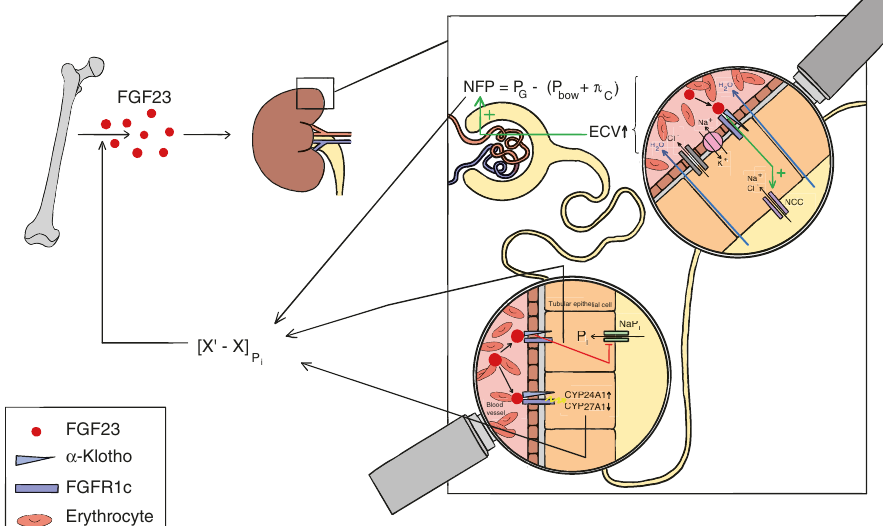
Fig. 1 Homeostatic functions of FGF23. Serum levels of phosphate are maintained within a tight range ([X ′ -X]) through constantly comparing the status quo (X) of circulating phosphate abundance with a prede fi ned set-point (X ′ ). If phosphate levels rise above the upper boundary of this range, FGF23 is induced, although the precise mechanism underlying phosphate-driven FGF23 secretion remains elusive. FGF23 restores phosphate homeostasis through its effects on the kidneys: In the proximal tubule, FGF23 reduces phosphate reabsorption by downregulating Natrium/Phosphate Cotransporters (NaP i s), inhibition of 25-OH-Vitamin D activation through downregulating CYP27A1 as well as enhanced catabolism of 25-OH-Vitamin-D via upregulation of CYP24A1. The latter two changes also decrease intestinal phosphate uptake. Moreover, FGF23 enhances sodium and chloride reabsorption in the distal tubule by fostering Na + /Cl − Cotransporter (NCC) activity, which yields an expansion of extracellular volume (ECV). This, in turn, increases systemic as well as glomerular blood pressure (P G ), thereby enhancing net glomerular fi ltration pressure (NFP) and thus, phosphate fi ltration. The two opposing forces of P G restricting NFP are the hydrostatic pressure within the capsular of Bowman (P Bow ) and glomerular capillary oncotic pressure ( π c ), i.e., [NFP = P G -(P Bow + π c )]. Collectively, these adaptations contribute to the phosphate-lowering effects of